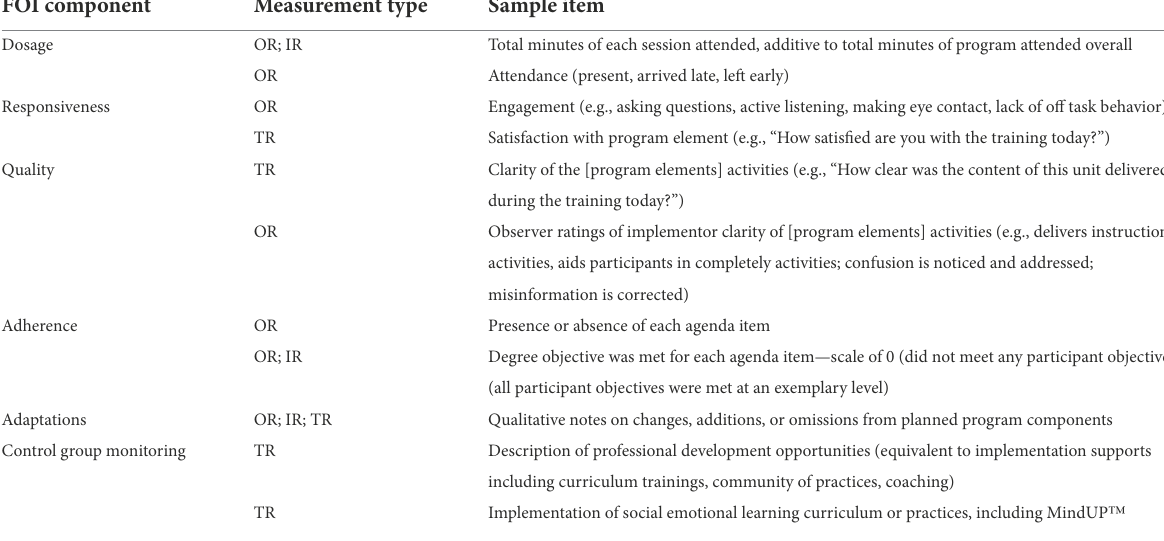
TABLE 4 Examples of fidelity of implementation items and